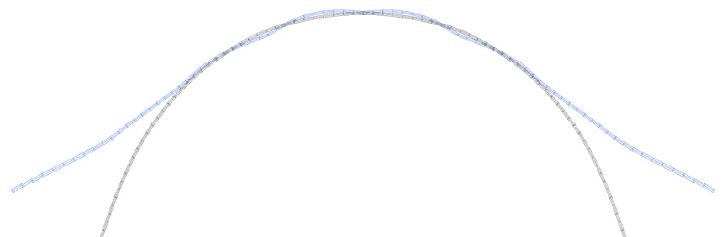
Figure 17. Transverse lath before relaxation of the structure ( Stage 4 ) in black, and deformed shape after relaxation in blue (amplification factor = 40).